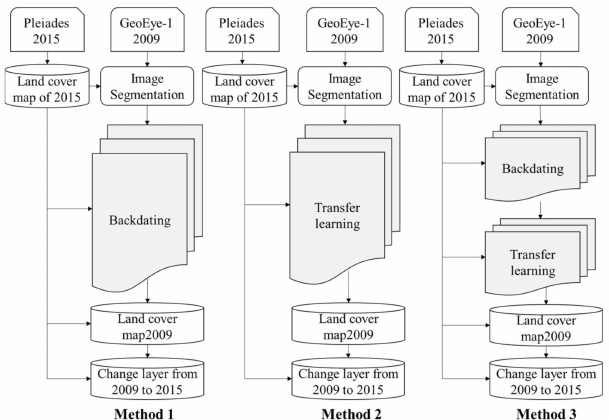
Figure 2. Flowchart of classification and change analysis. Method 1: backdating; Method 2: transfer learning; Method 3: integration of backdating and transfer